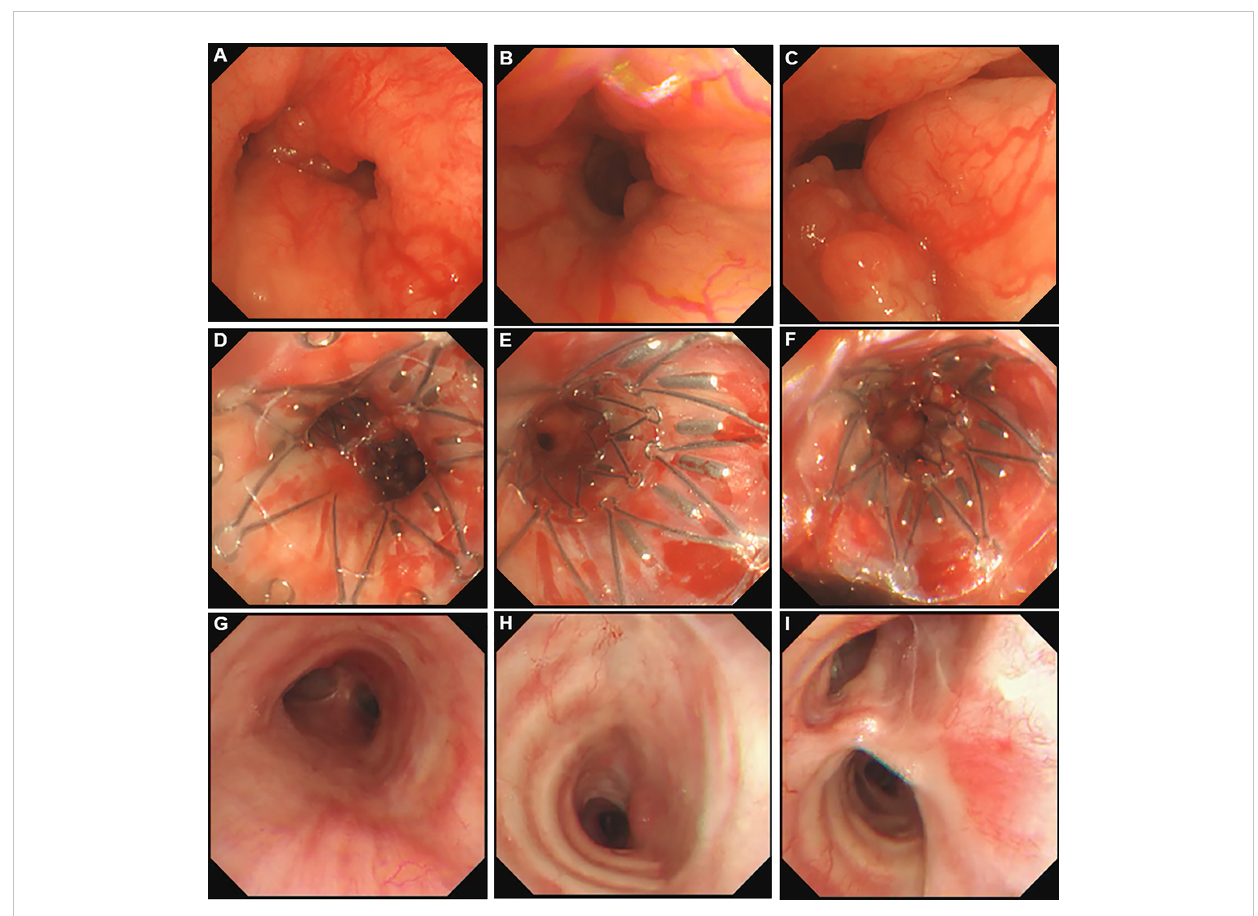
FIGURE 2 Bronchoscopy pictures in central airway. (A) Adenoid cystic carcinoma (ACC) in lower trachea. (B) ACC in left main bronchus. (C) ACC in right main bronchus. (D) Stent carrying 125 I seeds in lower trachea. (E) Stent carrying 125 I seeds in left main bronchus. (F) Stent carrying 125 I seeds in right main bronchus. (G) lower trachea 35 months after removing the stent. (H) Left main bronchus 35 months after removing the stent. (I) Right main bronchus 35 months after removing the